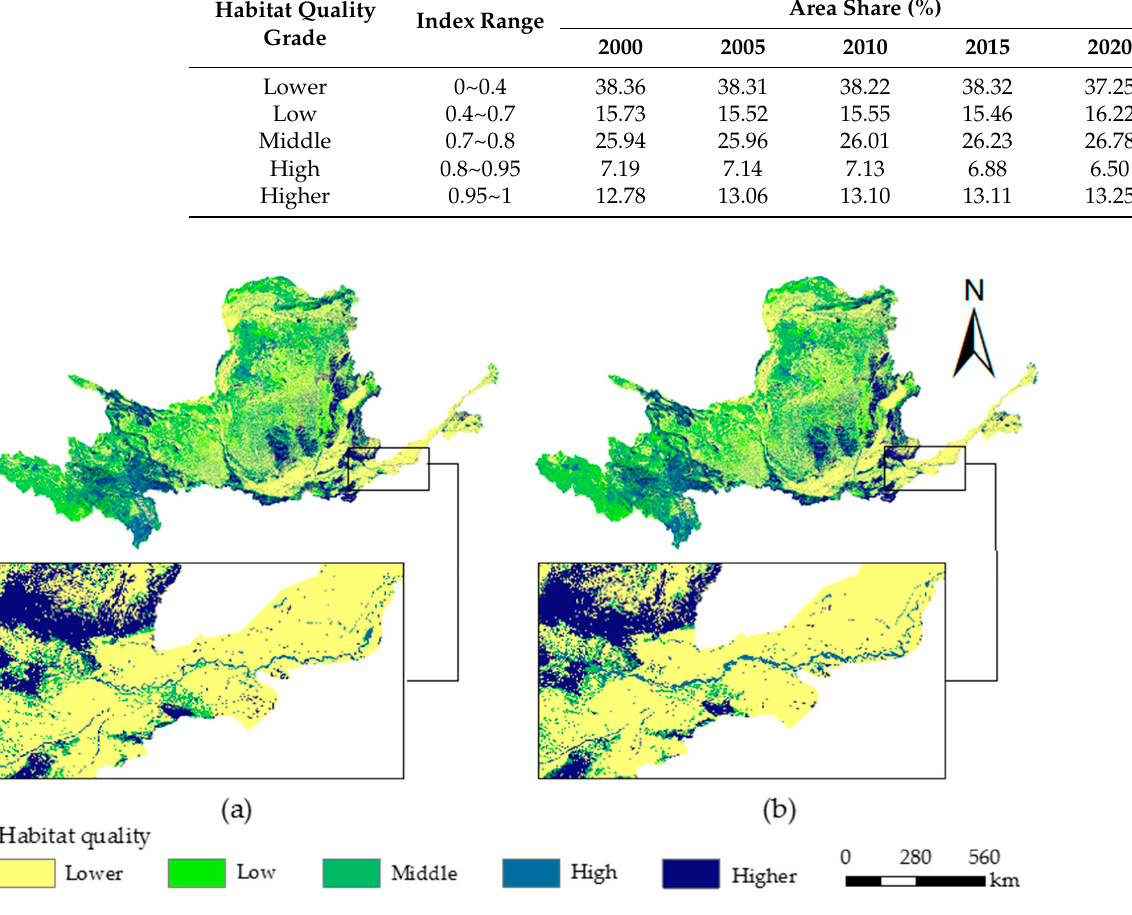
Figure 7. Habitat quality in the Yellow River Basin: ( a ) 2000 and ( b ) 2020.